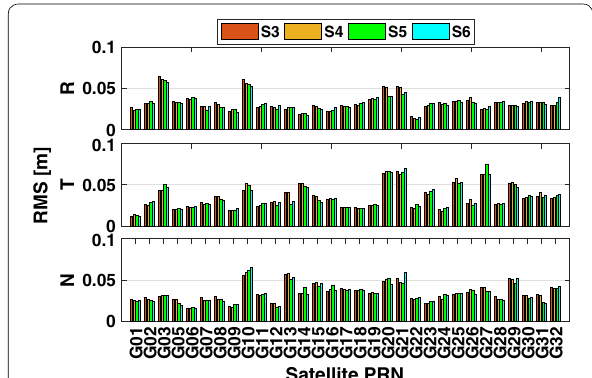
Fig. 12 GPS OBD of each satellite